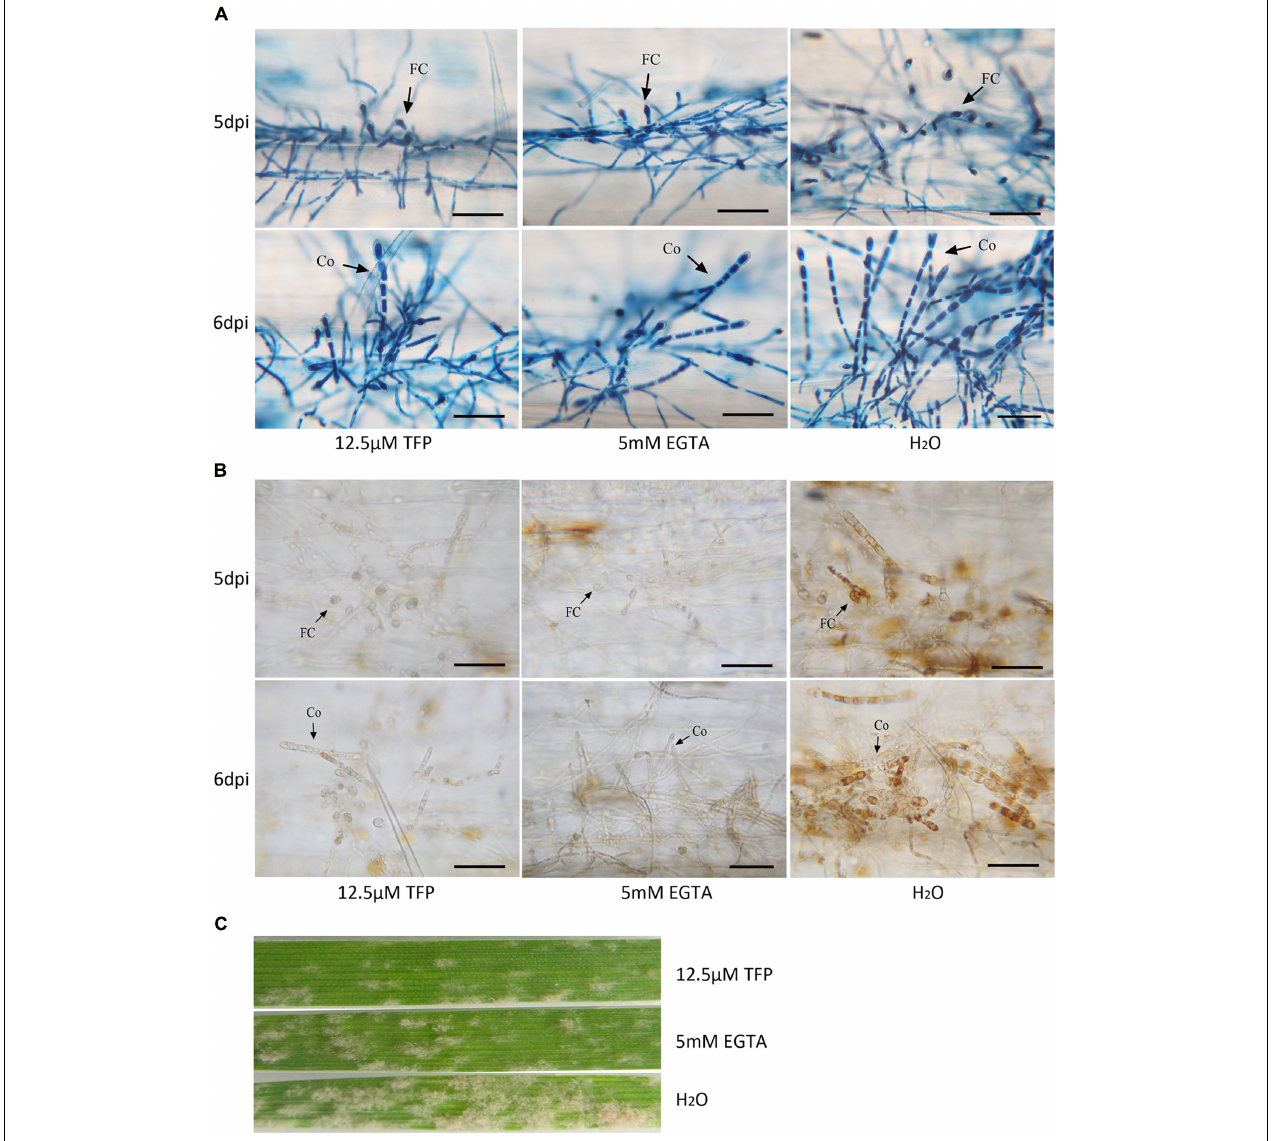
FIGURE 8 | The foot cell and conidiophore development and H 2 O 2 accumulation during Bgt sporulation on Chancellor when treated with 5 mM EGTA and 12.5 µ M TFP. Microscopy pictures for the trypan blue (A) and DAB staining (B) are given. Diseased leaf segments were also photographed at 10 dpi (C) . Bar: 50 µ m; FC, foot cell; Co,